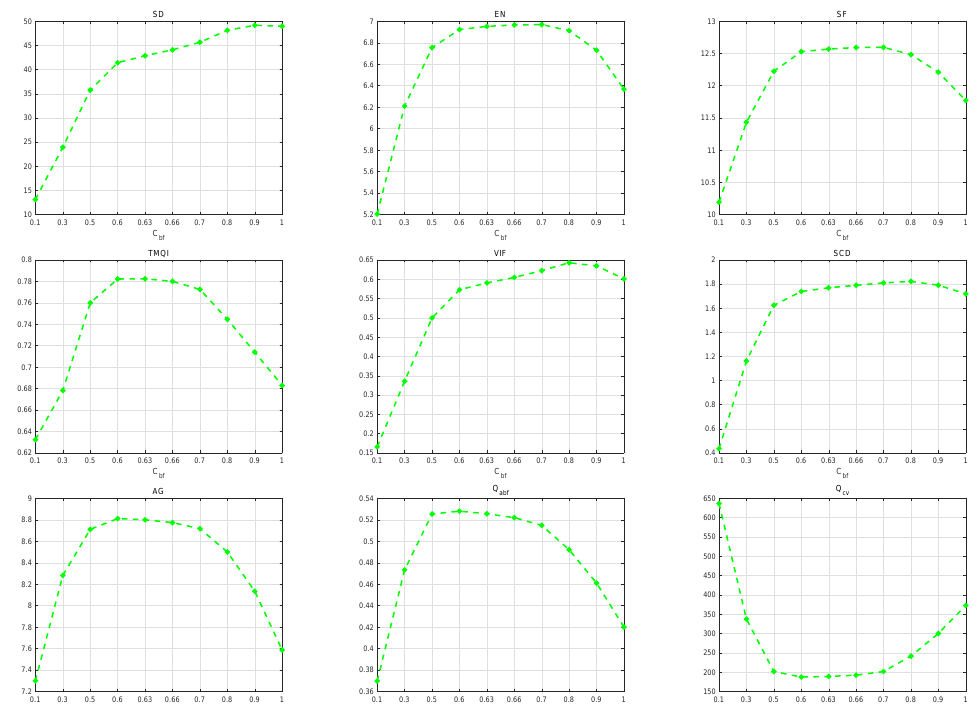
Figure 6. Influence of the parameter C bf on the objective metrics. The average values of each metric are obtained testing on the 21 image pairs. From left to right, C bf = 0.1, 0.3, 0.5, 0.6, 0.63, 0.66, 0.7, 0.8, 0.9, 1.